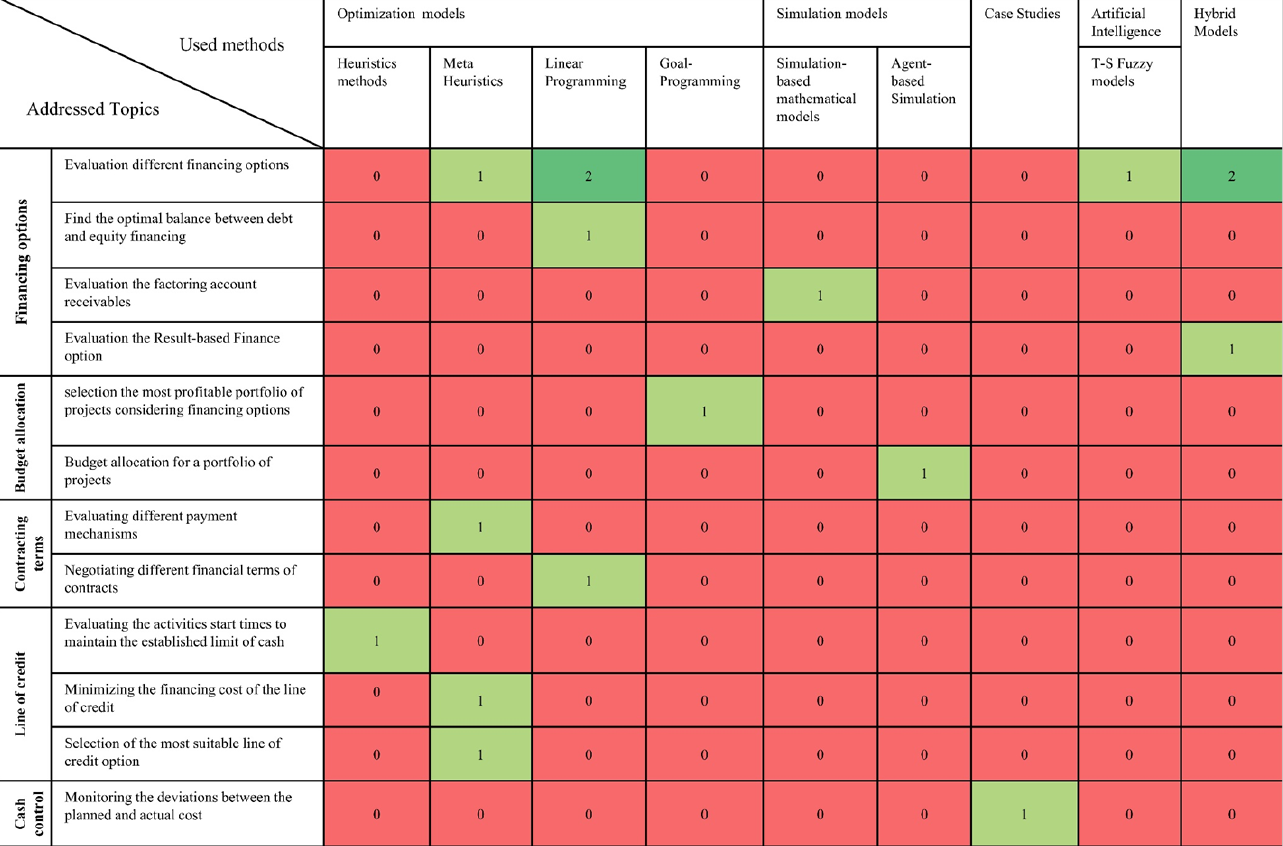
Figure 9. Classification of cash flow-based capital structure articles and applied methods.